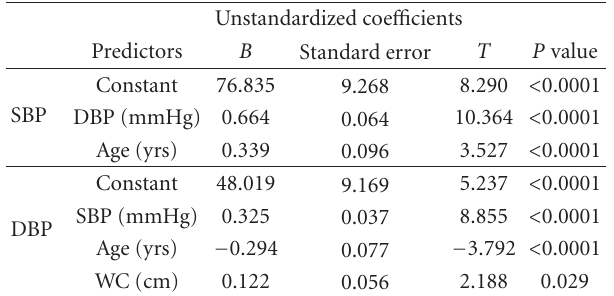
Table 4: Regression analysis of systolic and diastolic blood pressure with